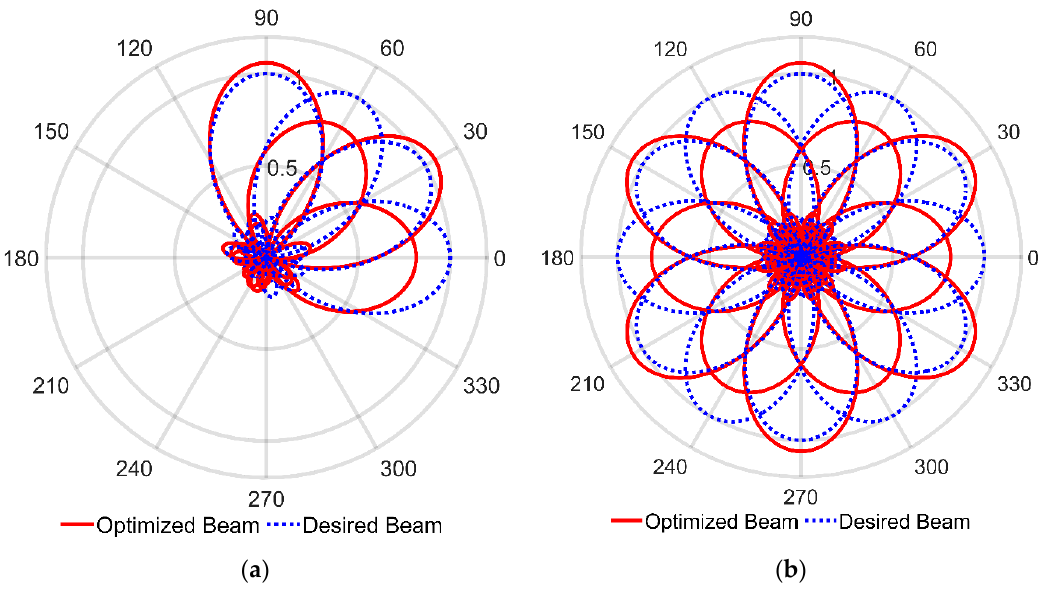
Figure 8. Beam Patterns of Two-Triangular Configuration: ( a ) Beam to 0°, 30°, 60°, and 90°, ( b ) Rotated beams.